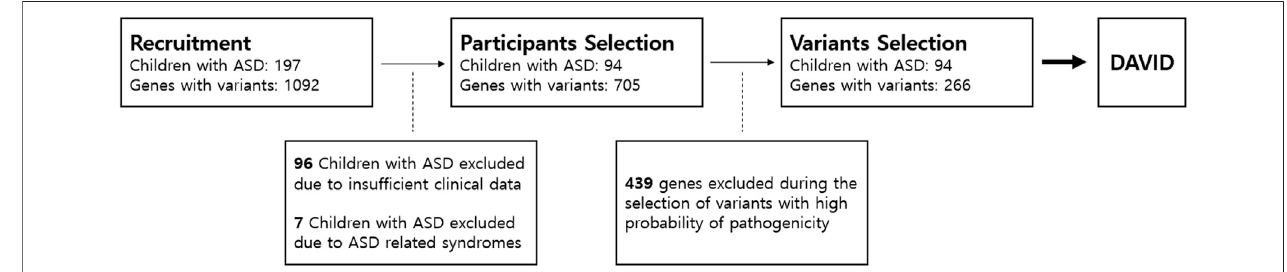
FIGURE 1 | Participants and gene selection. We fi rst recruited 197 children with ASD who underwent next-generation sequencing analysis. In total, 1,092 genes were detected with variants in NGS. We only included participants whose clinical assessment was complete with no missing data. After participant selection, we only selected fi ve variants that were most likely pathogenic in each patient based on ACMG guidelines. A total of 439 genes with variants were excluded. Only 266 genes remained from participant and variant selection. The 266 genes were included in enrichment analysis using the Database for Annotation, Visualization and Integrated Discovery (DAVID). ASD, autism spectrum disorder.